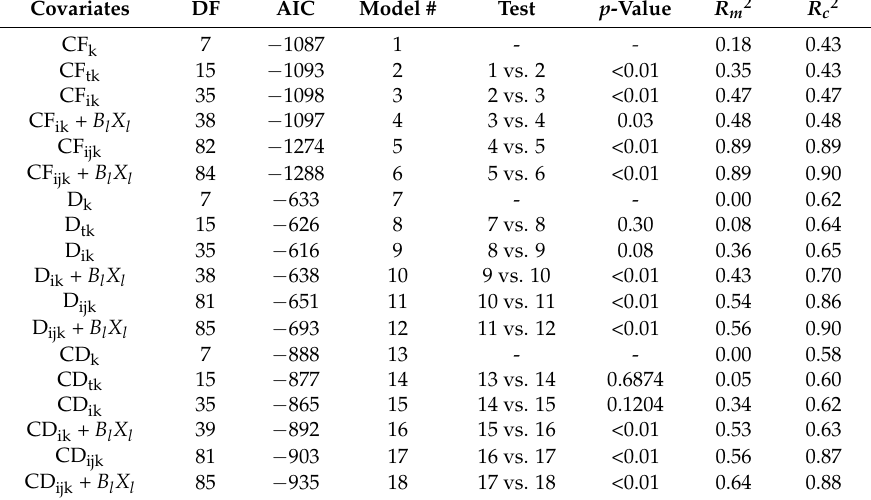
Table 5. ANOVA results for comparisons of nested tree property models. All models were regressed using maximum log-likelihood methods. Test column shows model numbers that were compared. The p -values result from log likelihood ratio tests for listed comparison. B l X l represents combinations of parameters and covariates fit to the model, CF is mean carbon fraction, D is mean tissue density, and CD is mean carbon density at a given model level. Nested model levels were: method (k), bark group (tk), species group (ik), species-tissue type groups (ijk). R m2 is the r-square value of the given model with fixed-effects only, while R c2 is the r-square value for the model with fixed and random-effects. Covariates